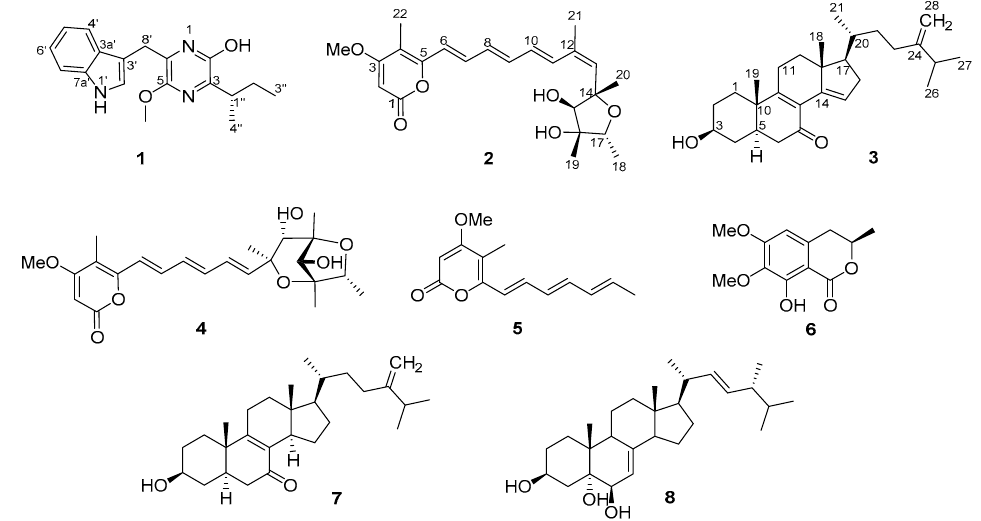
Figure 1. Structures of compounds 1 – 8 from Penicillium sp. IMB17-046.